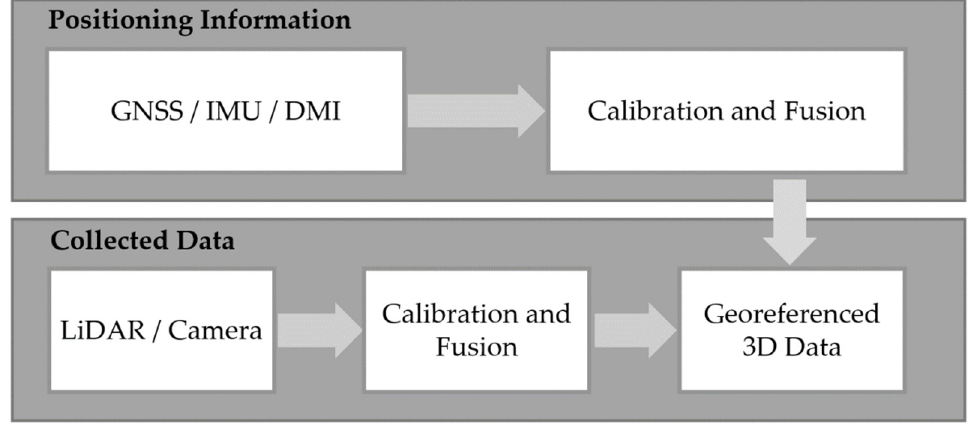
Figure 5. The standard processing pipeline for MMS data.